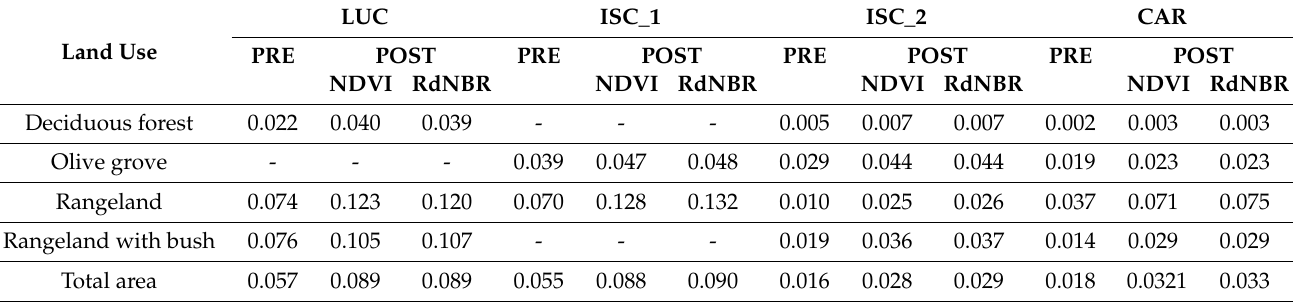
Table 6. Average values of erosion (t/ha) per land use in pre-fire, NDVI and RdNBR post-fire scenarios.